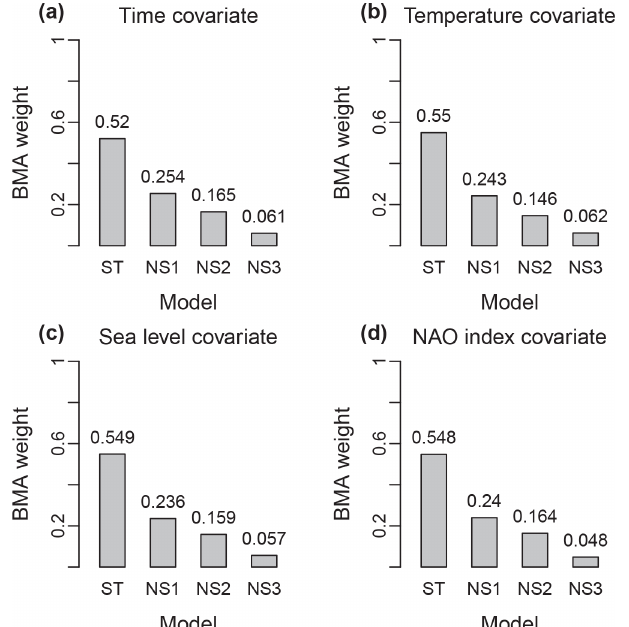
Figure 1. Bar plots showing the Bayesian model averaging weight for each of the four candidate models (ST, NS1, NS2 and NS3) using the following as a covariate: (a) time, (b) temperature, (c) sea level and (d) NAO